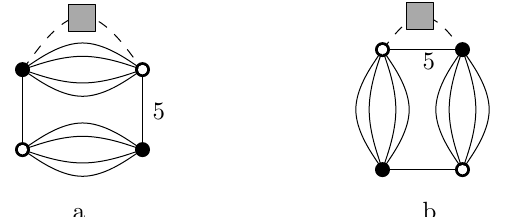
Figure 2. The two graphs contributing to the interaction V ( 1 ) of degree two. Melonic ( a ) and non-melonic ( b